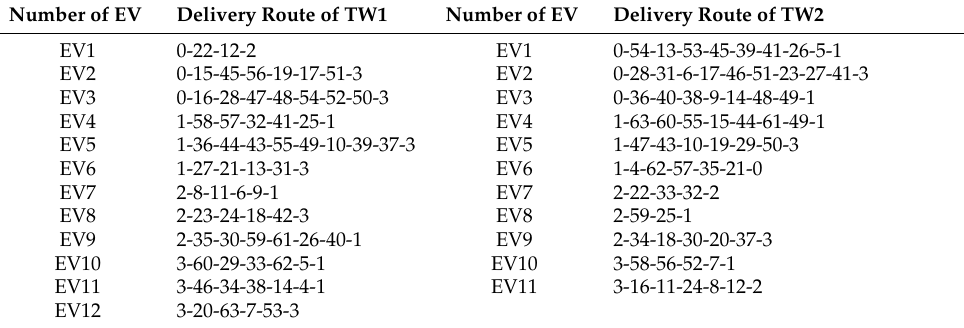
Table 7. The specific routes of the delivery scheme for case